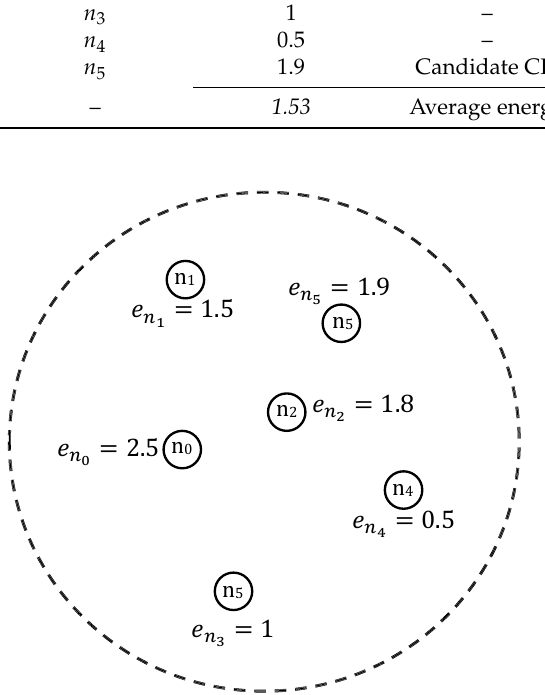
Case2: {n0, n5} are candidate cluster head nodes. Figure 2. Case1: Nodes { n 0 , n 2 , n 5 } are candidate cluster head nodes.